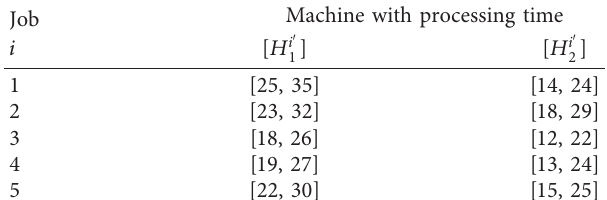
Table 5: Modified machine processing